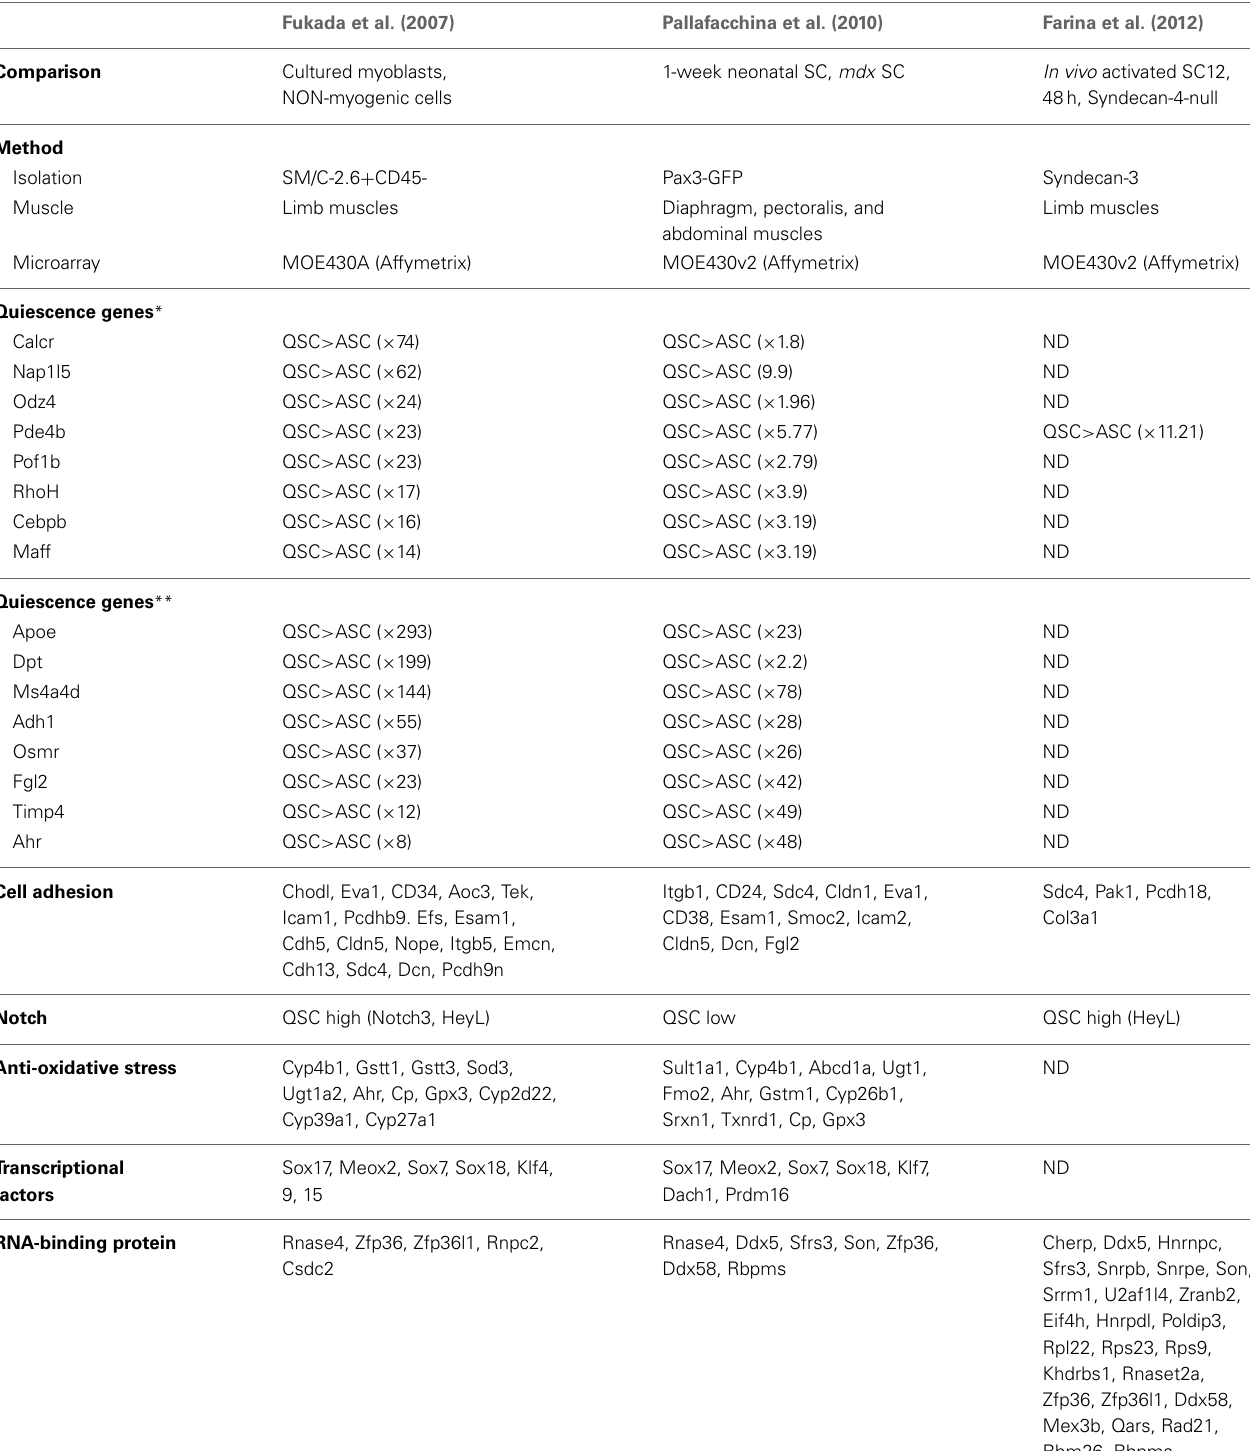
Table 3 | Molecular signatures of quiescent satellite cells identified by three independent